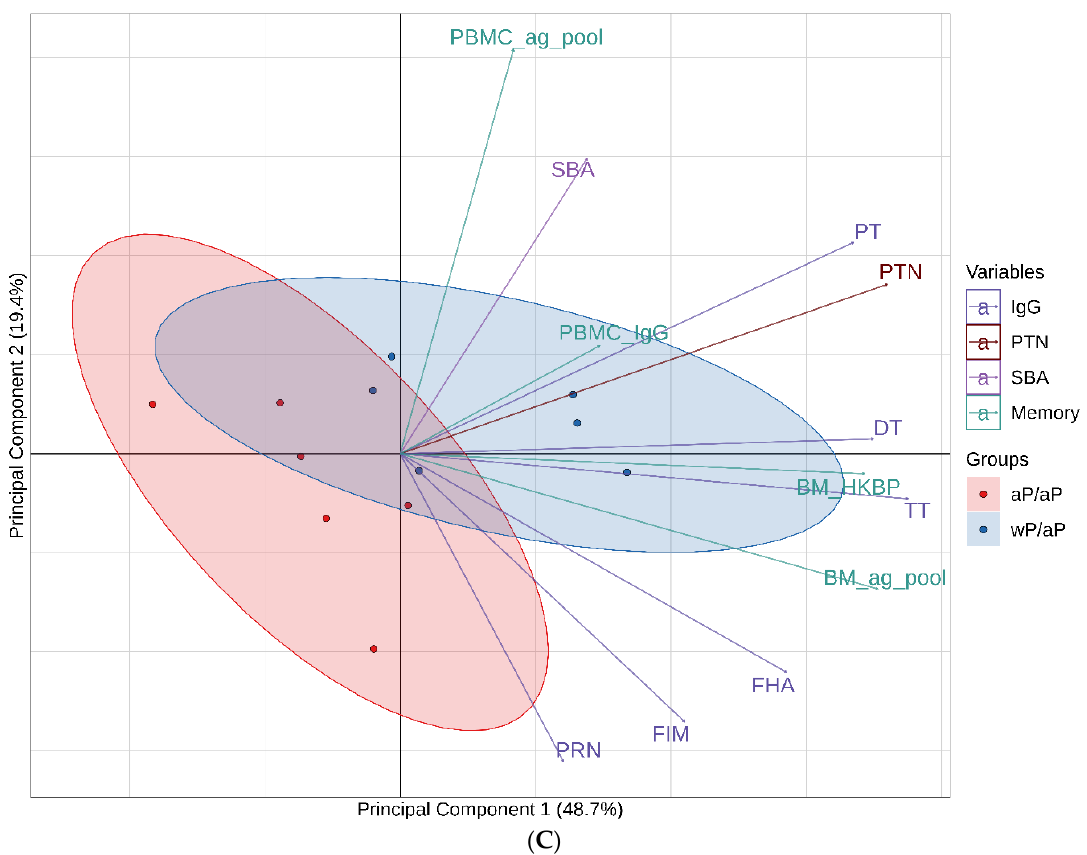
Figure 8. PCA of immune responses on days 57 ( A ), 196 ( B ), and 609 ( C ) reveals distinct immunological signatures. PCA was performed using data generated from the post primary immunizations day 57 samples as well as the post boost day 196 or 609 samples. There were 43 different variables incorporated into the day 57 PCA, 45 variables incorporated into the day 196 PCA, and 12 variables incorporated into the day 609 PCA. All variables included in the analyses are listed in Table S1. The most contributive variables to principal components 1 and 2 are listed in the biplots. For T cell ELISPOT data, variables are listed by the cytokine assessed, spot, and the specific recall antigen (e.g., IL17_spot_Bp). For T cell cytokine secretion after antigen recall the data is noted by the specific cytokine assessed followed by the recall antigen (e.g., IL17_Bp). For IgG antibody titers, data are noted solely by the name of the antigen (e.g., FHA). Serum bactericidal activity data is noted by SBA. PT-neutralizing activity data is noted by PTN (PT-neutralization). For B cell ELISPOT data, the source of the cells is listed as either bone marrow (BM) or PBMC along with the antigen specificity of the antibody produced by the cells.